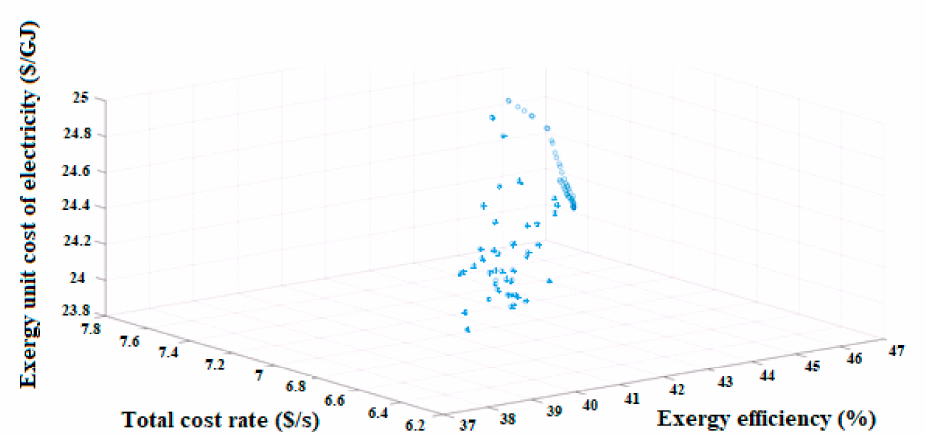
Figure 16. Pareto optimal solutions for the configuration shown in Figure